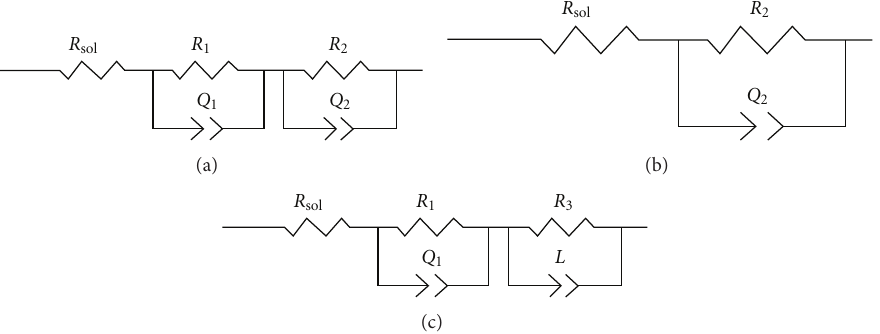
F 5: Equivalent circuits used for �tting the measured impedance spectra.